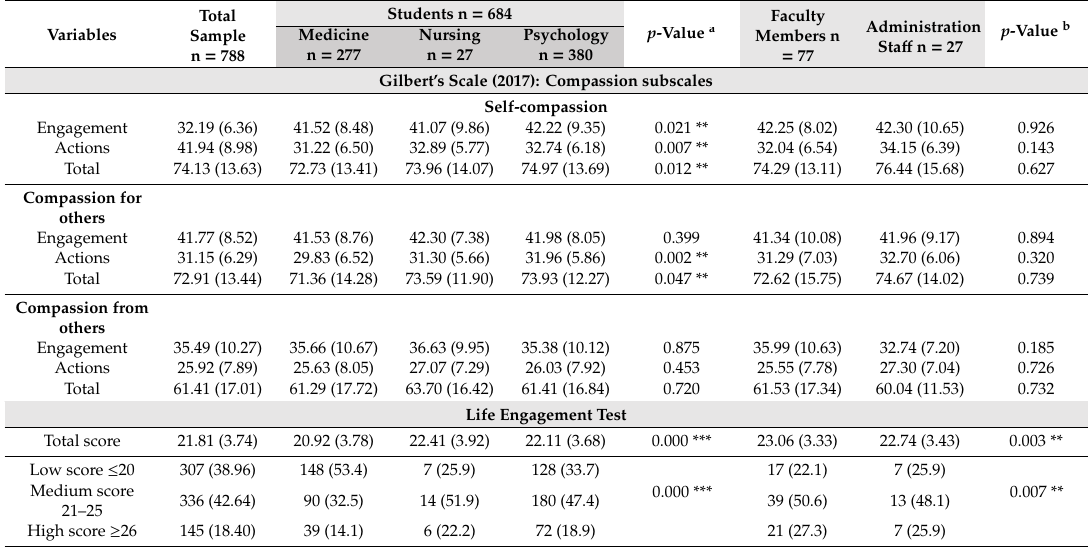
Table 4. Gilbert’s Scale and the Life Engagement Test by students’ course and a ffi liation (n = 788). Variables